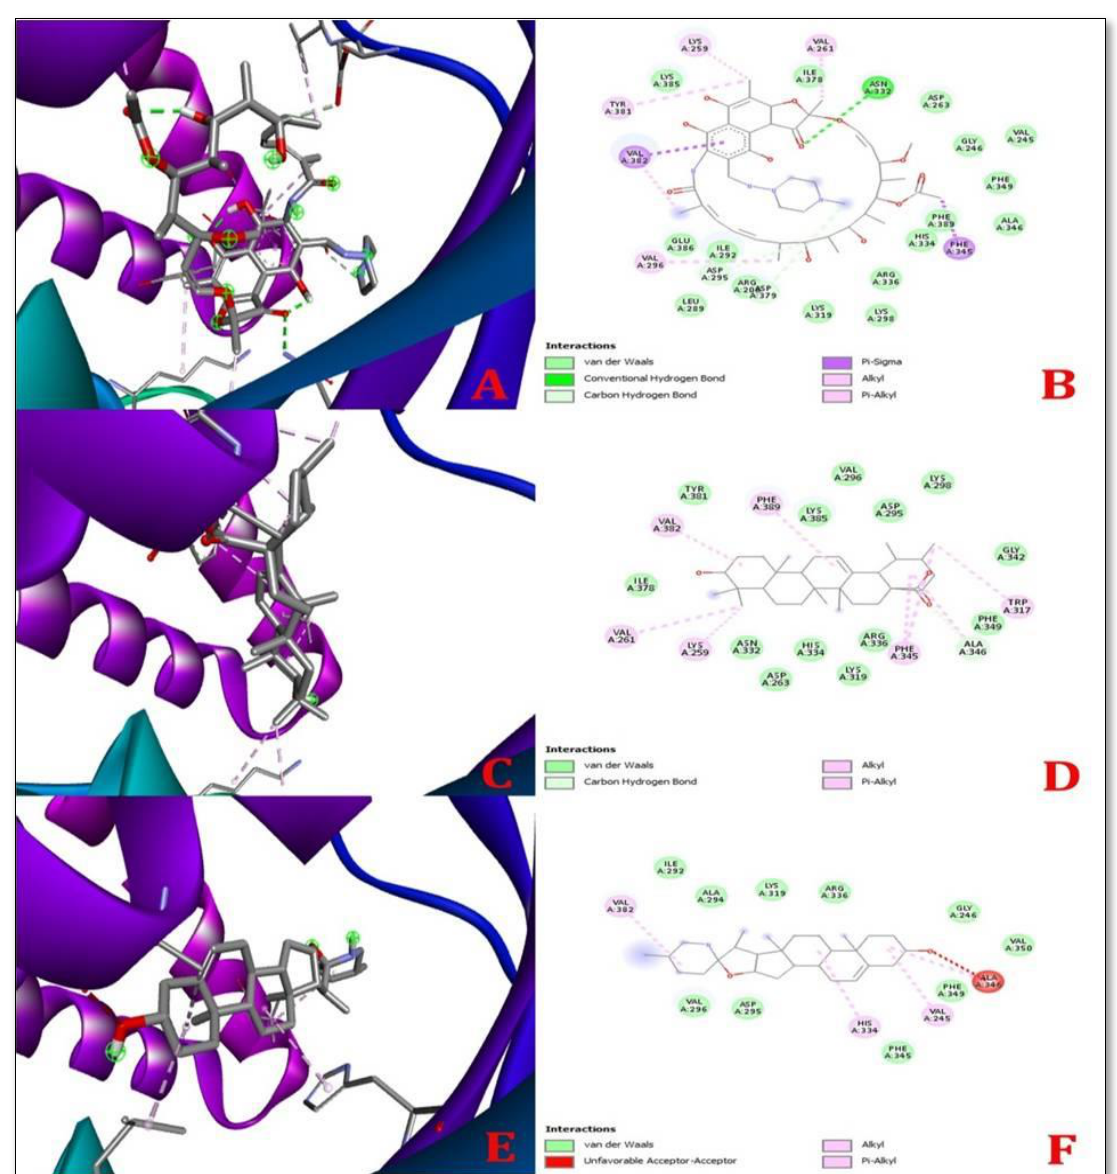
Figure 2. 3D (left) and 2D (right) representations of the best pose interactions between receptors and ligandsregarding the MAP Dephospho-Coenzyme A kinase (DPCK) Protein ( A , B ) interaction between Rifampicin (control) and DPCK protein, ( C , D ). Interaction between ursolic acid and DPCK protein, ( E , F ). Interaction between solasodine and DPCK protein. Colored spheres indicate the type of residue in the target: green—conventional hydrogen bond (Asp), light green—carbon–hydrogen bonds (Asp and Ala), pink—pi-sigma (Val and Phe), light pink—alkyl and pi-alkyl (Val, Lys, Tyr, Ala, His, Trp, and Phe), and red—unfavorable acceptor. The protein pocket shows colored lines for the ligands suitable to the nearest atom. The interval between lines illustrates the opening of the protein pocket. In the 3D simulation, the ligands are shown using the stick model and the proteins are represented using the solid ribbon